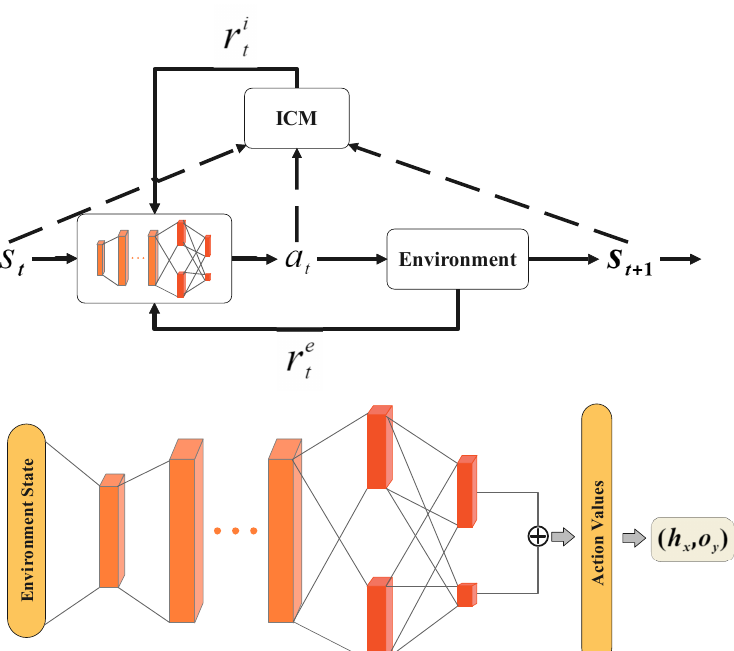
Figure 1. The learning cycle ( Top ) and schematic illustration of the NDSPI-DQN (bottom). ( Top ) The agent observes current environment state s t and outputs an action a t according to the learned policy; then, the external reward r e is obtained from the environment. Meanwhile, ICM takes ( s t , a t , s t + 1 ) as t input and outputs the internal reward r i . Both r i and r e are used to optimize the policy. ( Bottom ) t t t The details of the algorithm architecture are explained in Section 3.2. The orange layers denote fully connected layers and the red layers denote dueling network architectures with noisy linear layers.